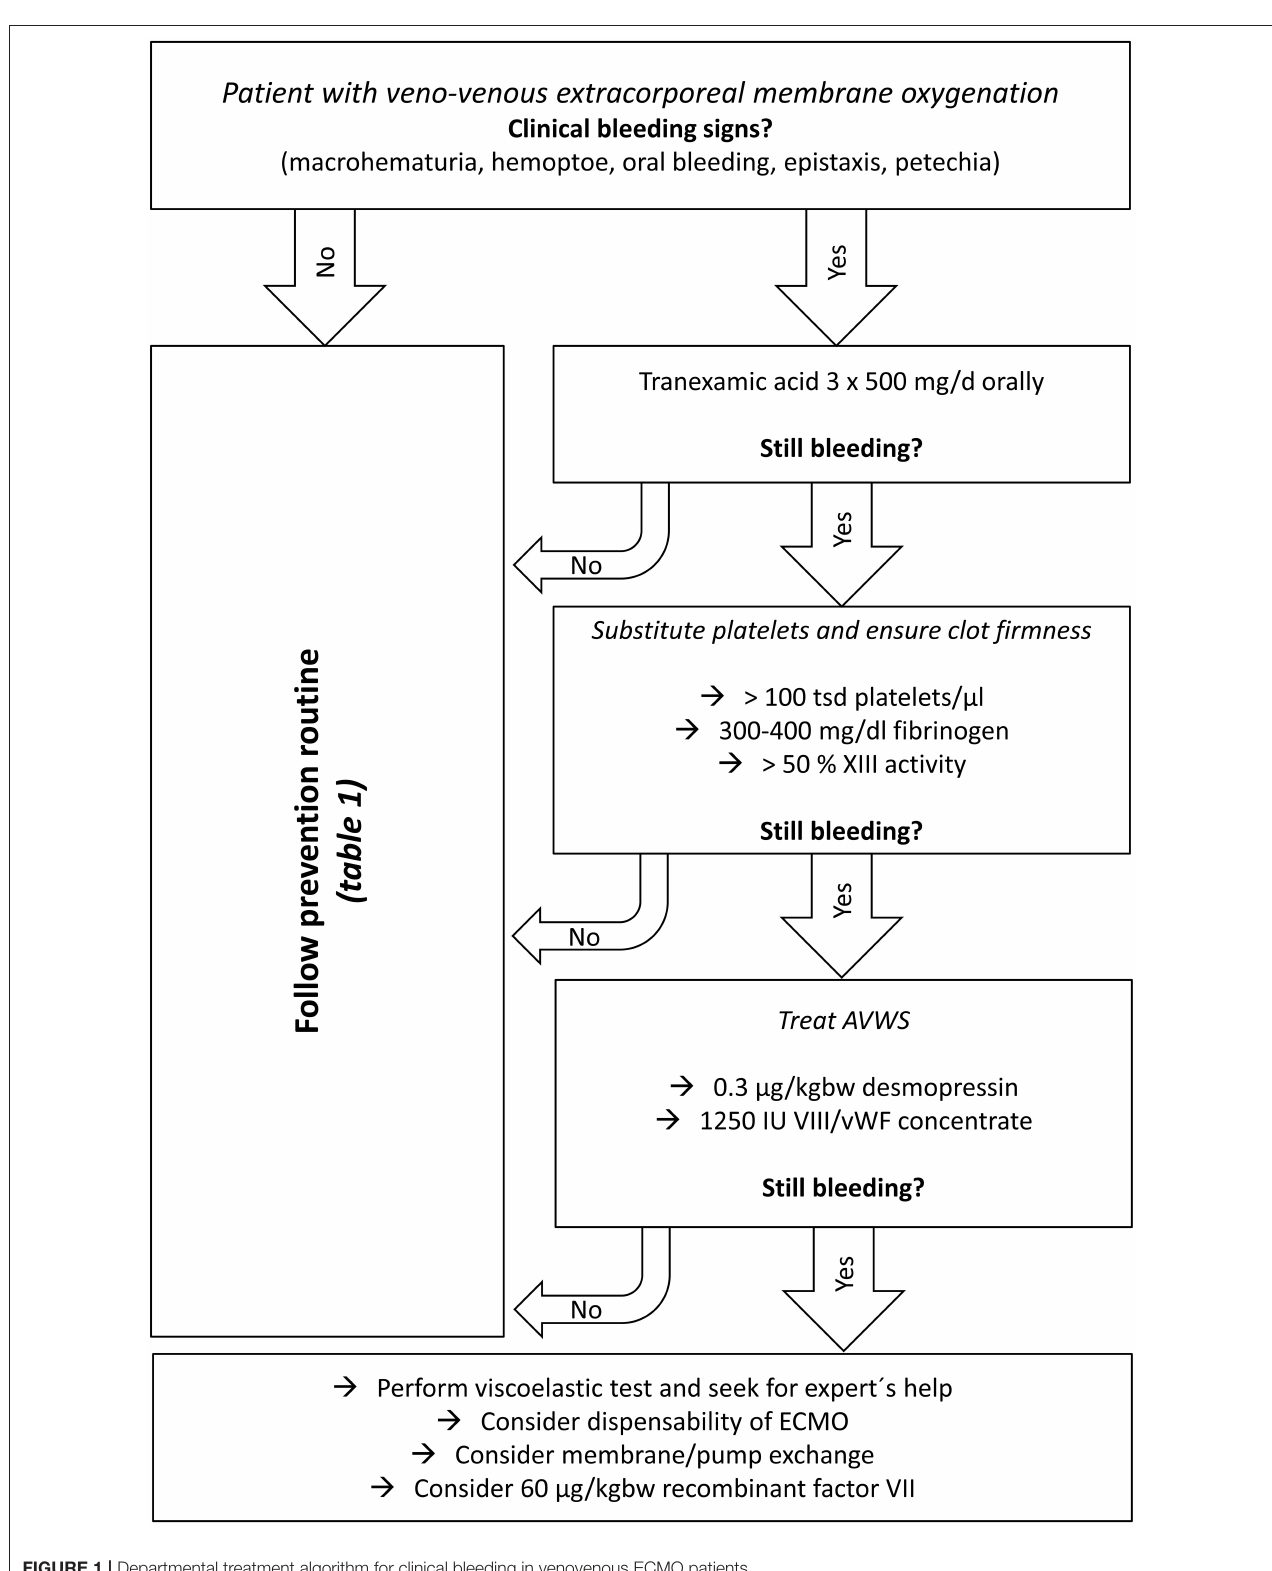
FIGURE 1 | Departmental treatment algorithm for clinical bleeding in venovenous ECMO patients.